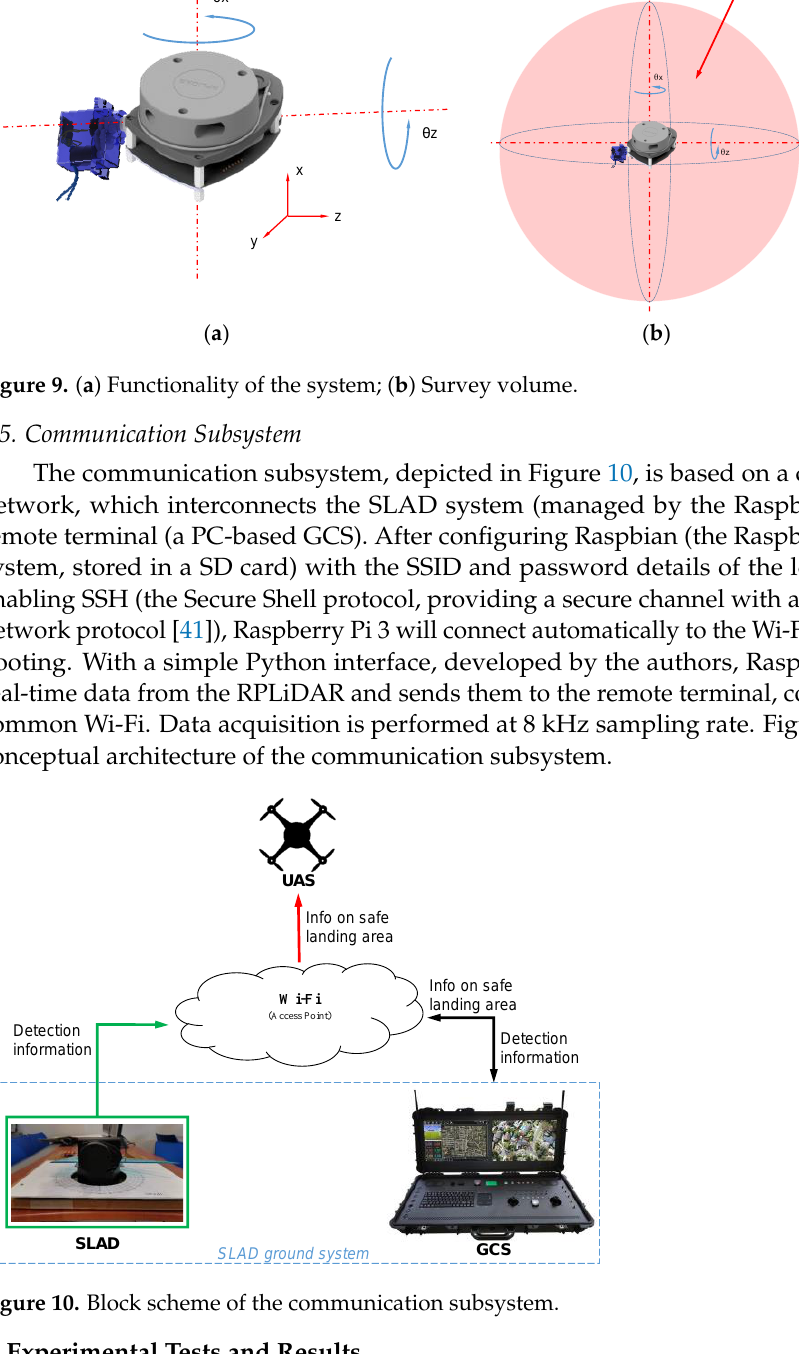
Figure 8. ( a ) Servo motor with rotating disc, to allow LiDAR rotation in the plane orthogonal to the laser rotation axis; ( b ) The prototype with a graduated disc allowing to take readings of the servo motor angular position α.